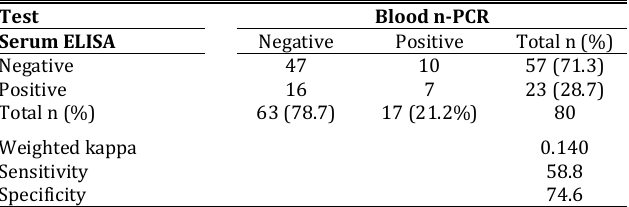
Table 3. Comparison between infection rates of Toxoplasma gondii in local Lactating goats using ELISA and n-PCR in blood